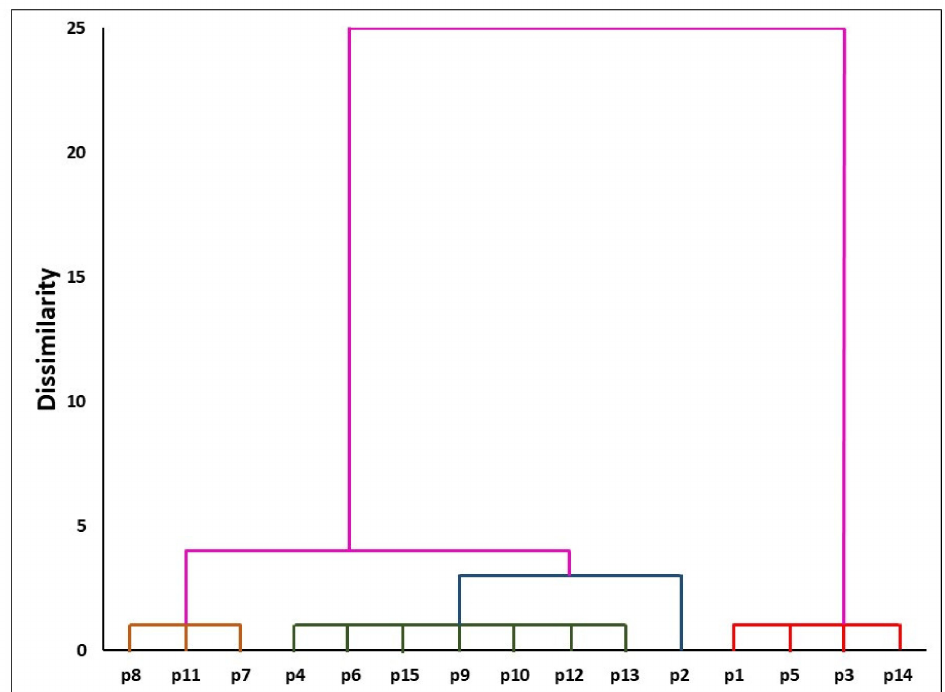
Figure 6. Agglomerative hierarchical clustering dendrogram showing clustering based on soil